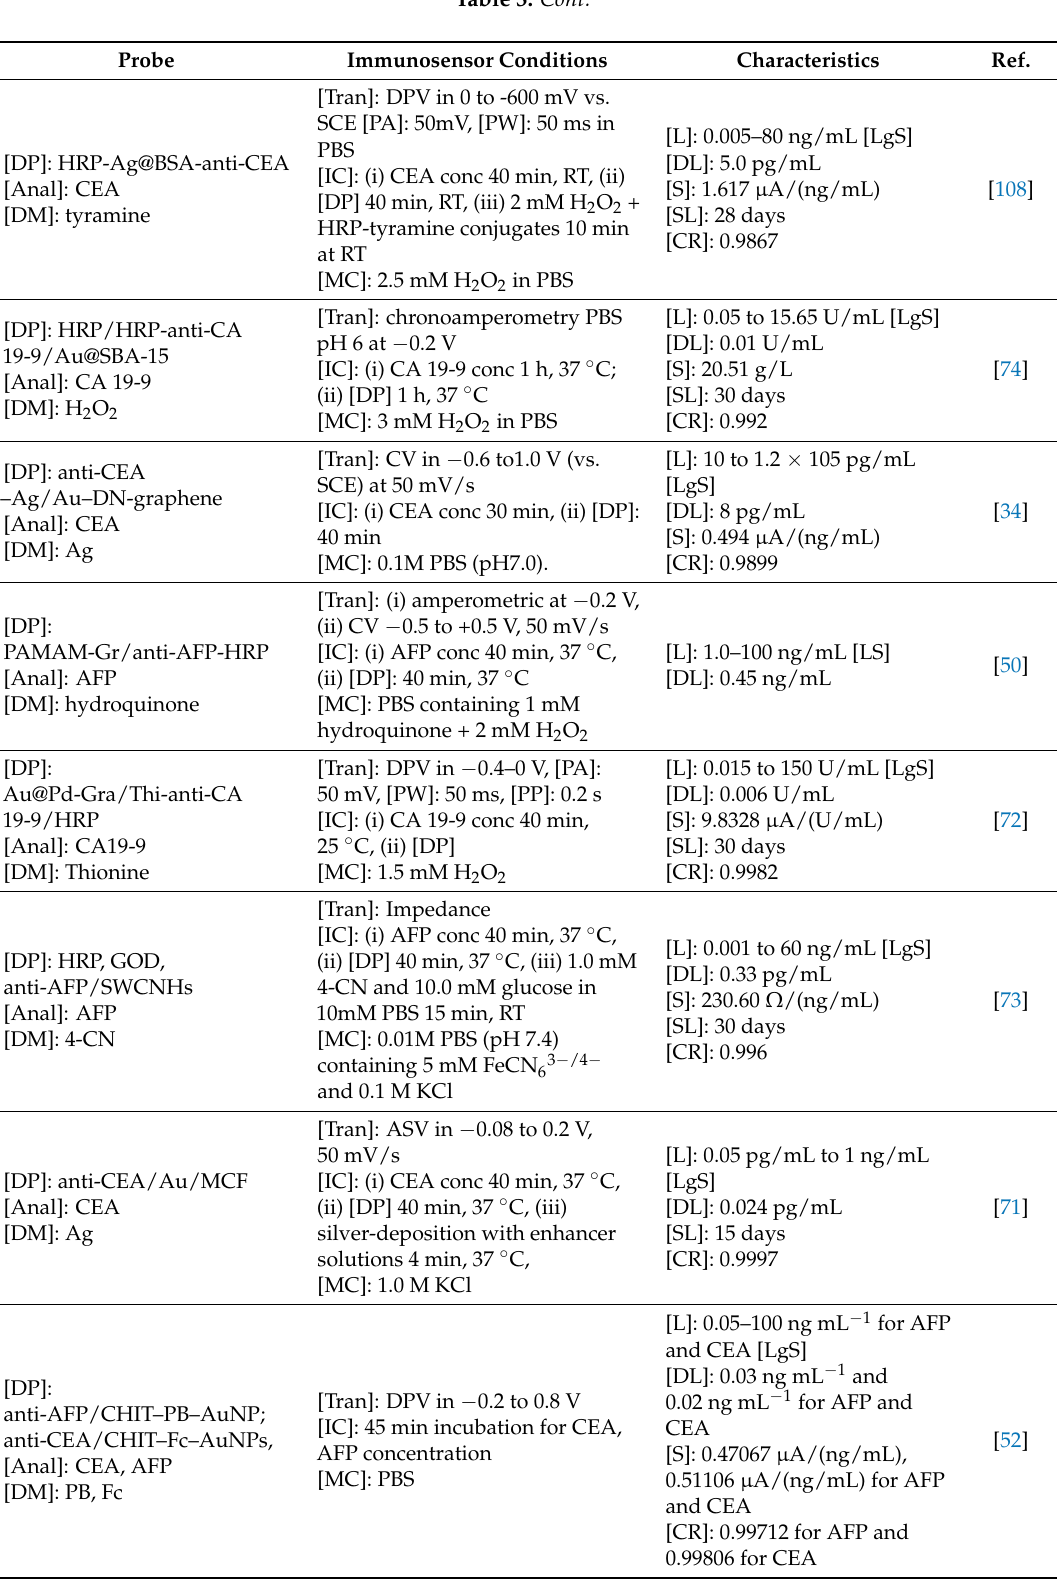
Probe Immunosensor Conditions Characteristics